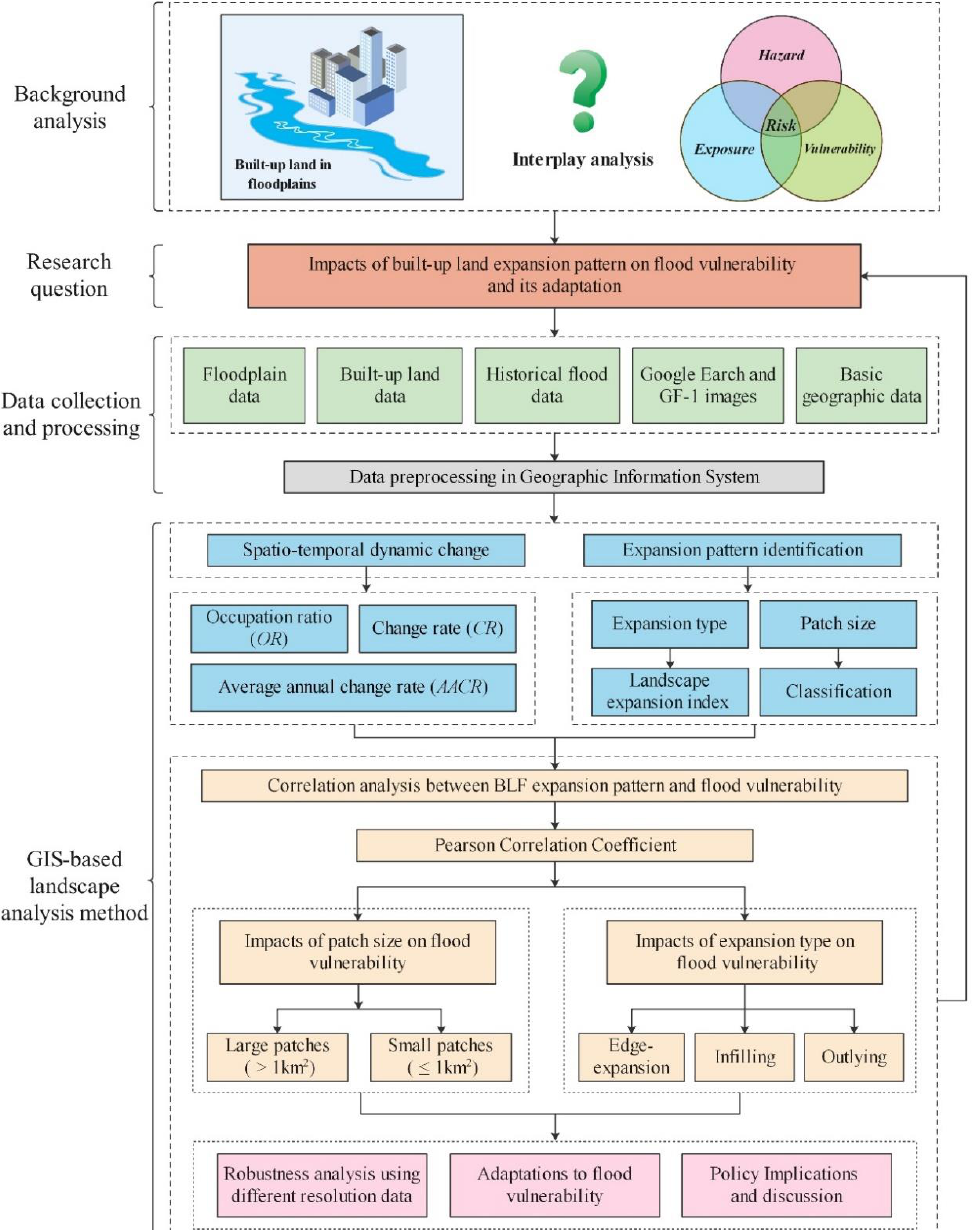
Figure 4. The overall framework of the impact of the built-up land in floodplains (BLF) expansion pattern on flood vulnerability and its adaptation strategies.